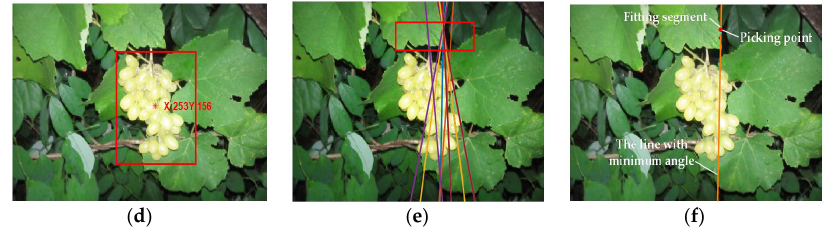
Figure 11. The error results of grape-detection and picking-point calculation. ( a , d ) Fruit area; ( b , e ) the region of interest (red box) and the Hough detection; ( c , f ) picking-point calculation.